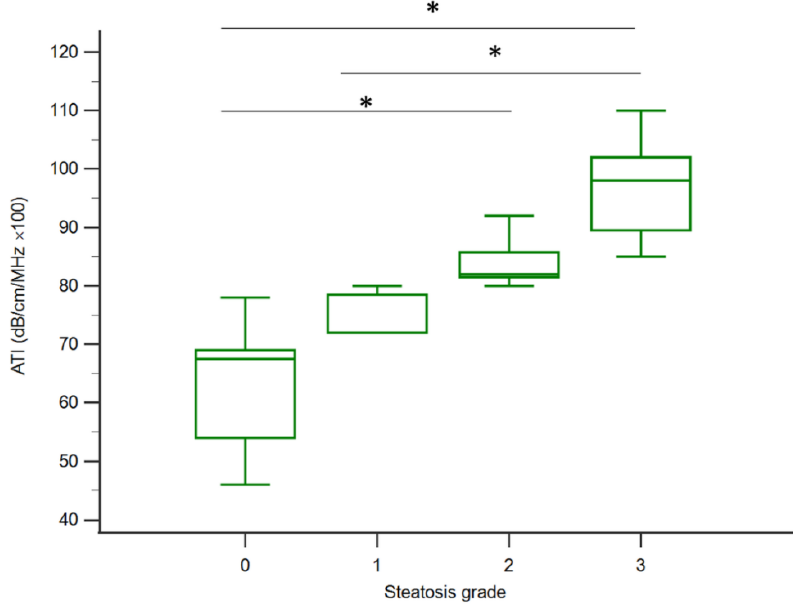
Figure 4. The distribution of ATI values according to the histologic steatosis grade. The ATI was significantly different between S0 and S2, S0 and S3, and S1 and S3 ( p < 0.05) with the Kruskal–Wallis test under post-hoc analysis. Although S2 and S3 did not reach a statistical difference, the ATI in S3 still trended higher than S2. The vertical axis is a logarithmic scale. The top and bottom of the boxes are the first and third quartiles. The length of each box represents the interquartile range, within which are located 50% of the values. The lines through the middle of the boxes represent median values; ATI: attenuation imaging; * p < 0.05.